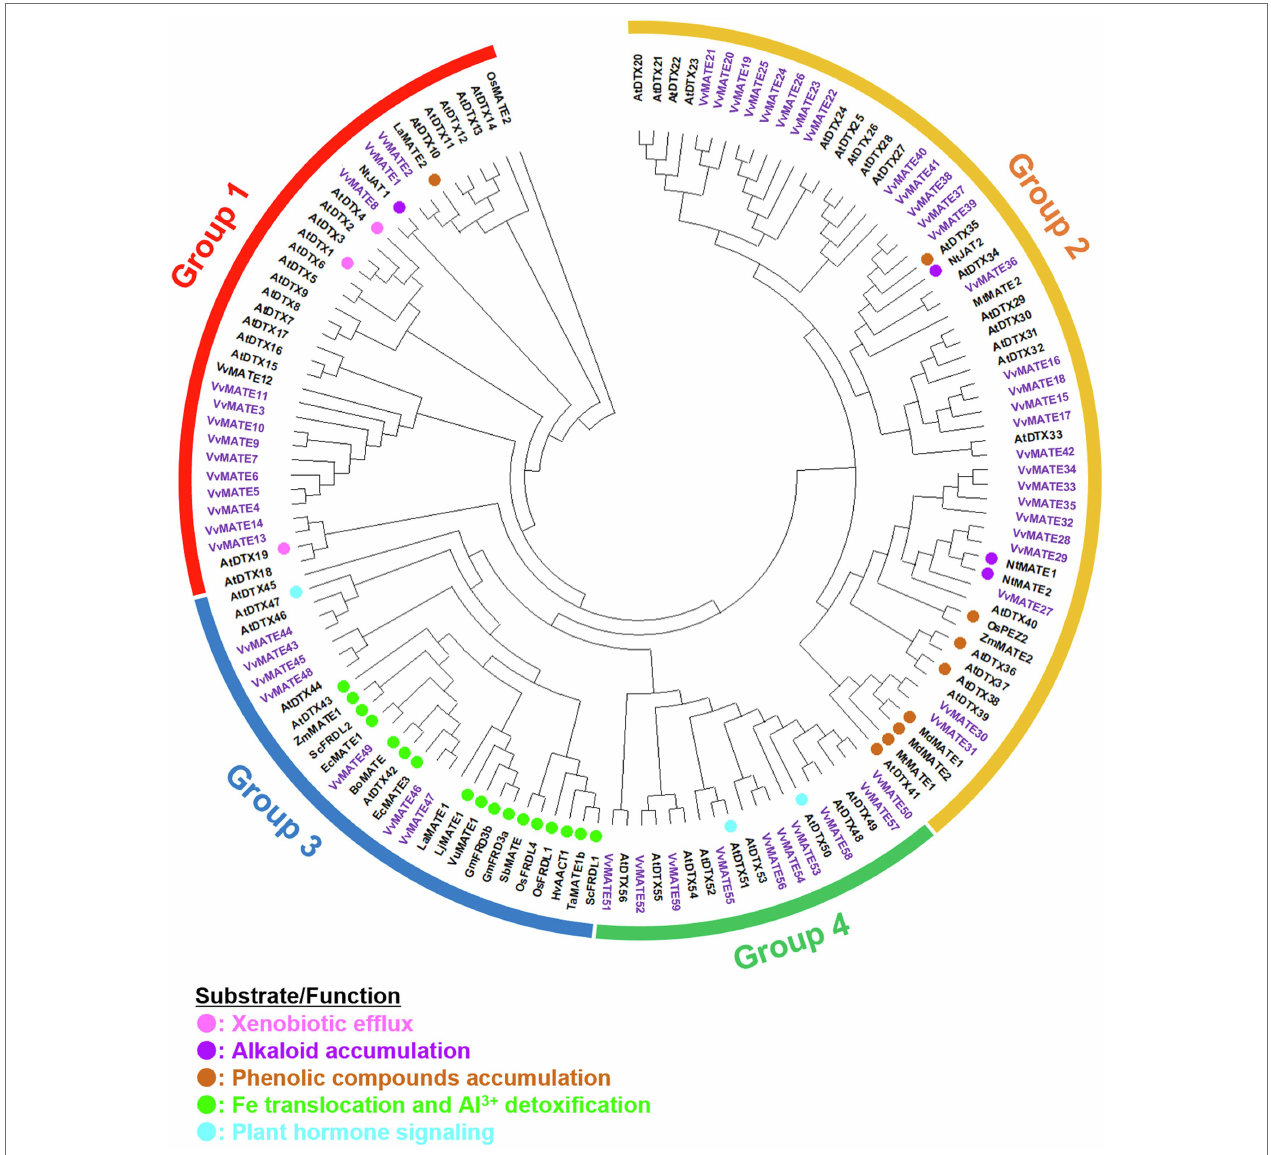
FIGURE 1 | Phylogenetic tree of the MATEs of grape and those of other plant species reported previously. Amino acid sequences of the MATEs of grape and those of other plant species (Li et al., 2002; Takanashi et al., 2014; Biala-Leonhard et al., 2021) were aligned using the ClustalW program. The phylogenetic tree was created by MEGAX using the neighbor-joining model. The grape MATEs are indicated with purple and the MATEs of other plant species are indicated with circle (different colors show different physiological functions, Takanashi et al.,